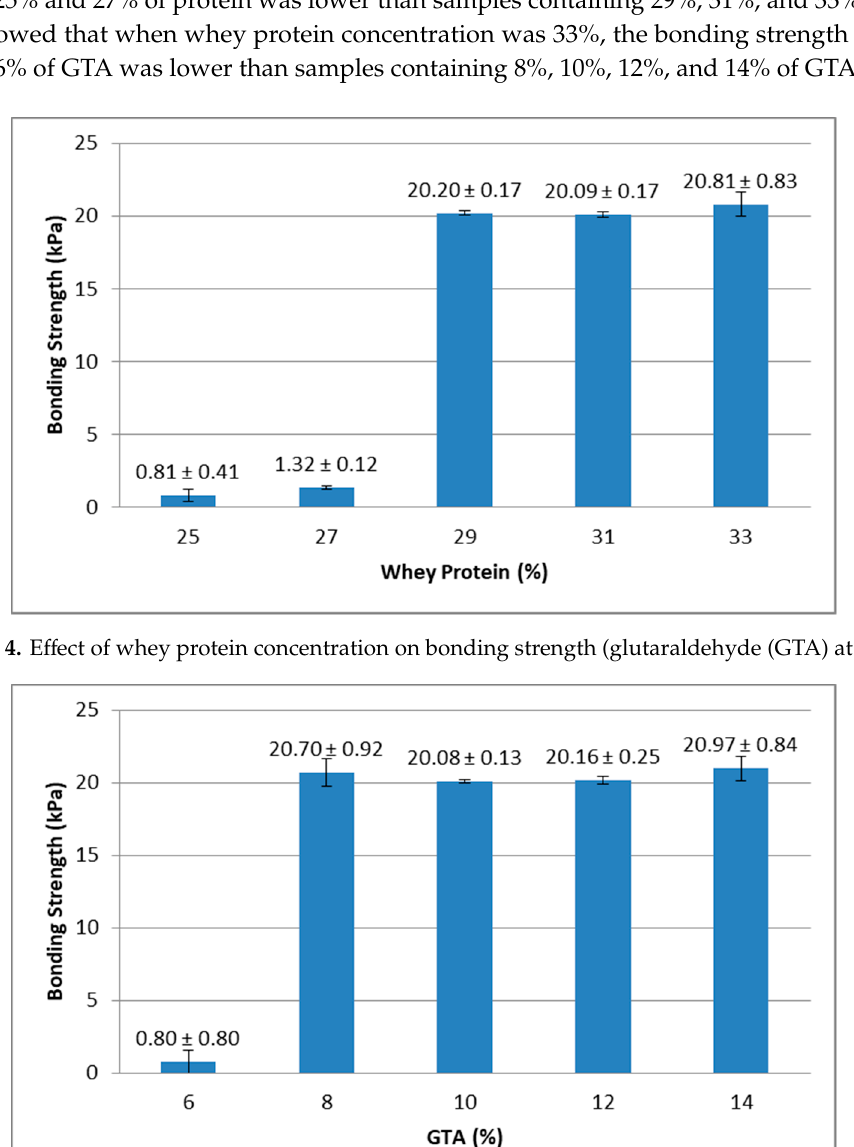
Figure 3. Time needed for antimicrobial effect of totarol.